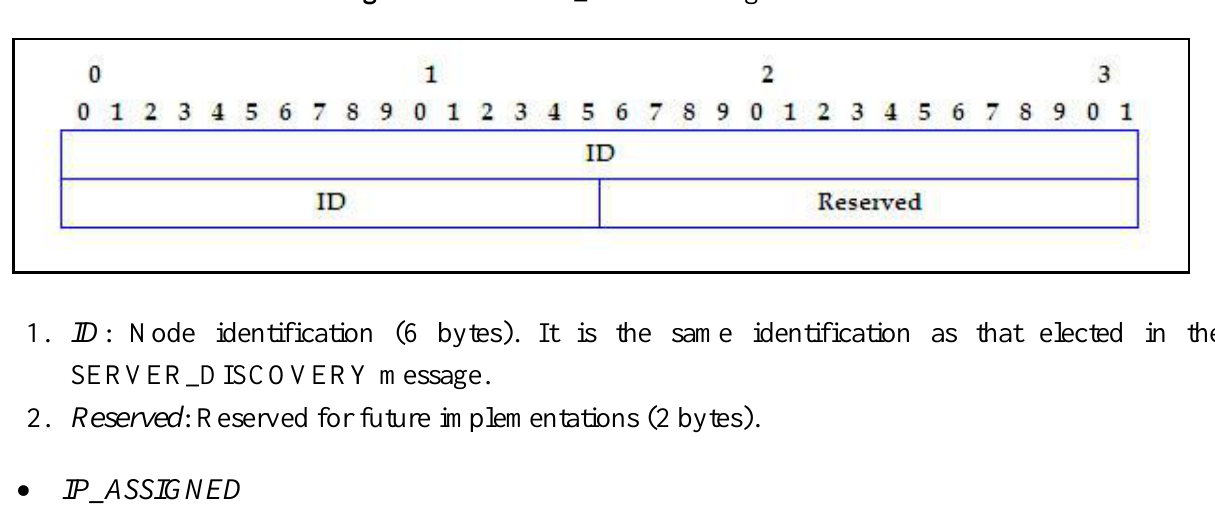
Figure 5. SERVER_POLL message